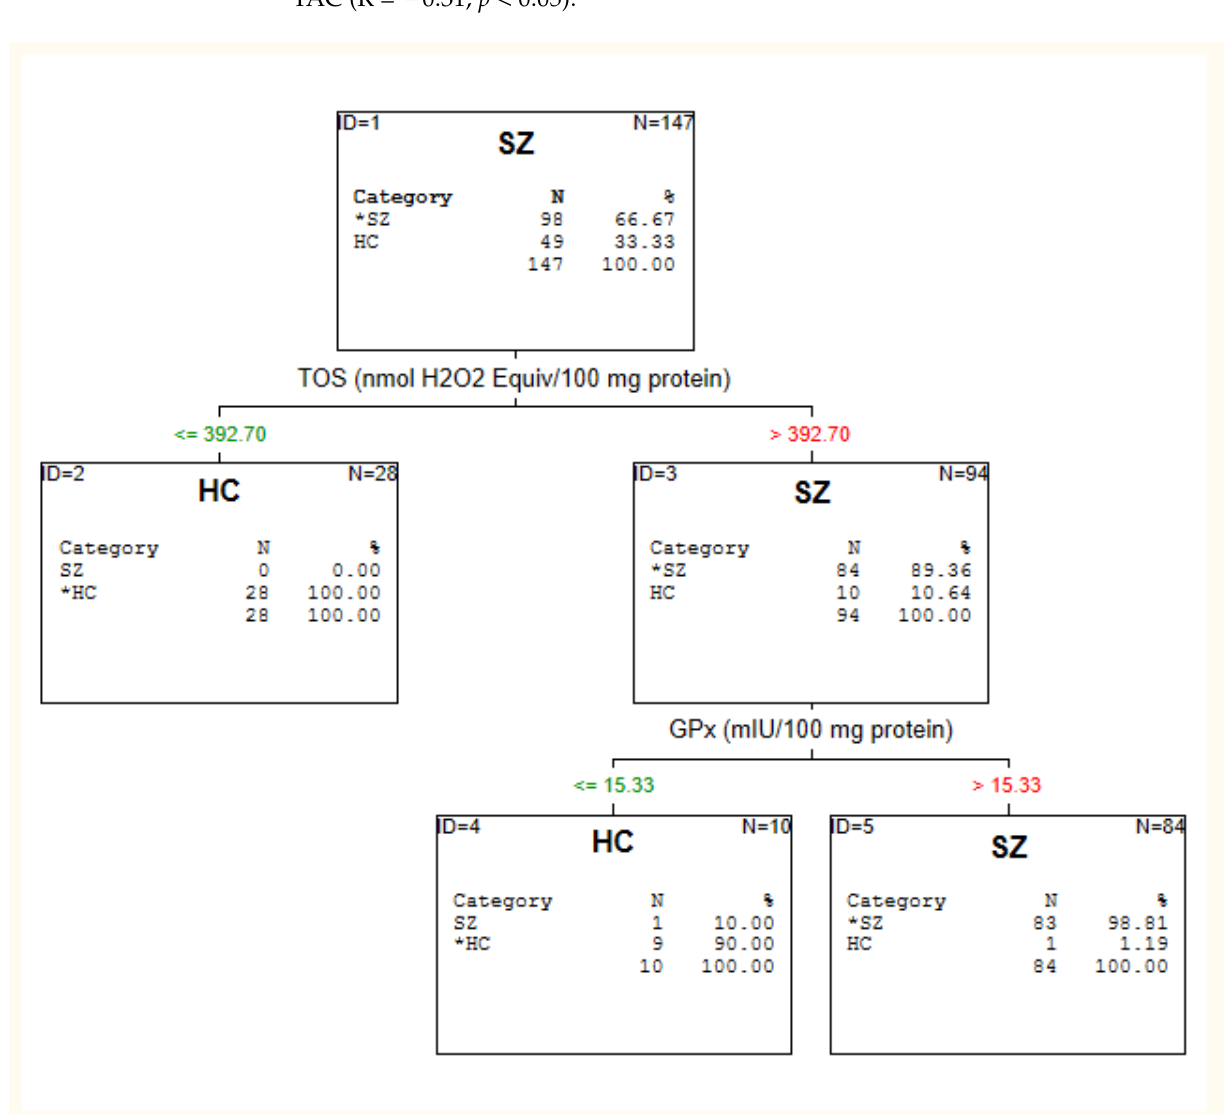
Figure 1. C&RT analysis for healthy individuals (HC) and schizophrenia patients (SZ).